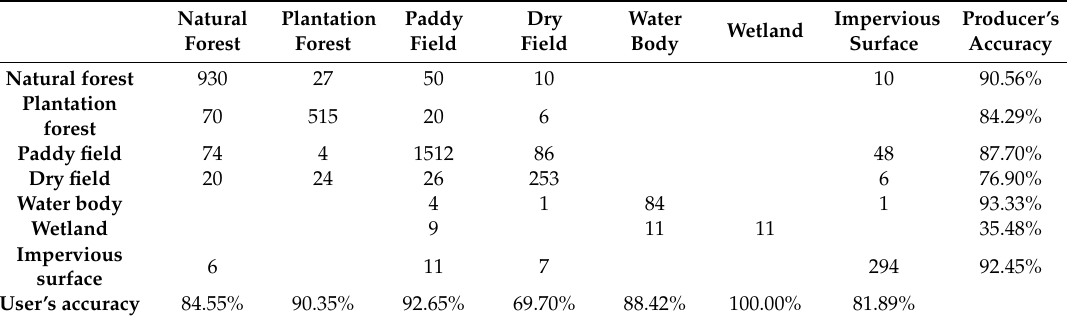
Table 5. Confusion matrix for SBTC